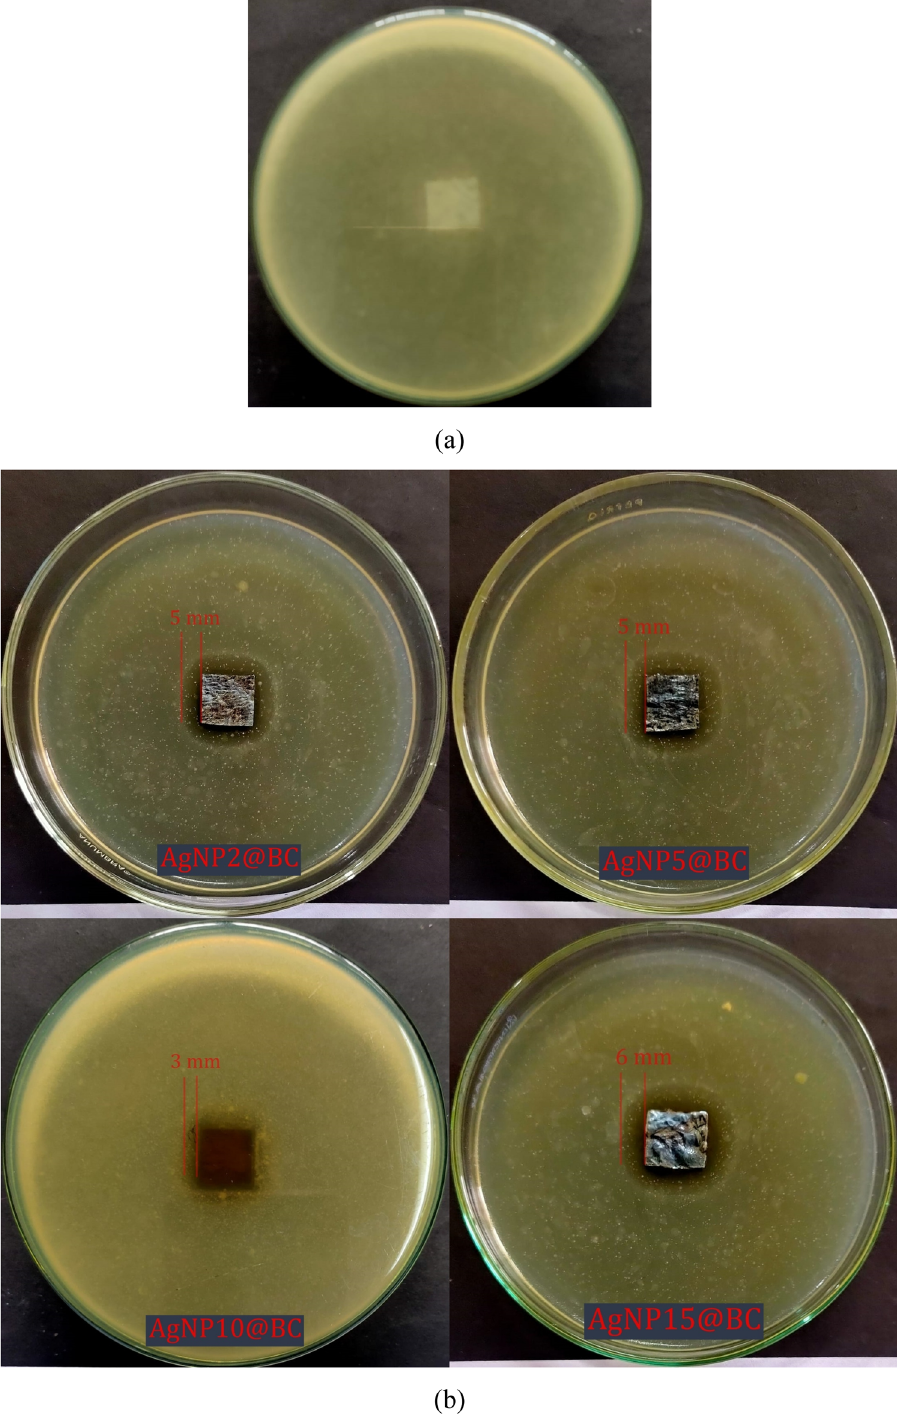
Figure 8: Antibacterial activity against S. aureus of: ( a ) pristine BC and ( b ) AgNPs templated